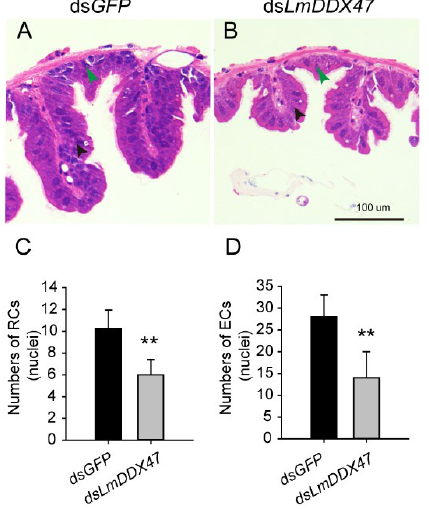
Figure 6. Effects of LmDDX47 on the gastric cecum of adult locusts. ( A , B ) Morphology of the gastric cecum of N5D7 nymphs after LmDDX47 RNAi. Green arrow heads indicate regenerative cells, and black arrowheads indicate epithelial cells in the gastric cecum. Scale bar = 100 µ m, n = 5. ( C , D ) Number of regenerative and columnar cells (nuclei) in each ridge of the midgut of N5D7 nymphs after LmDDX47 RNAi. RCs: regenerative cells; ECs: epithelial cells. ** p < 0.01, n =